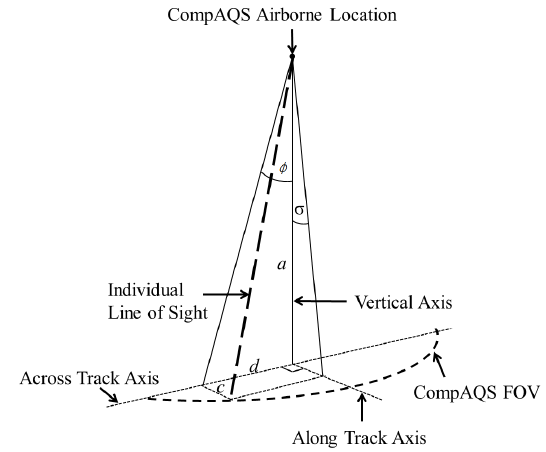
Figure 2. Schematic of the gridding process, showing the GPS loca- tion relative to the CompAQS field of view (curvature exaggerated for display purposes) shown as the black curve.